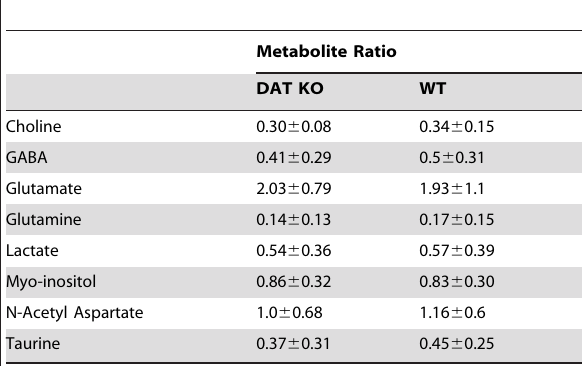
Table 1. Relative metabolite concentrations in striatum of DAT KO and WT mice are